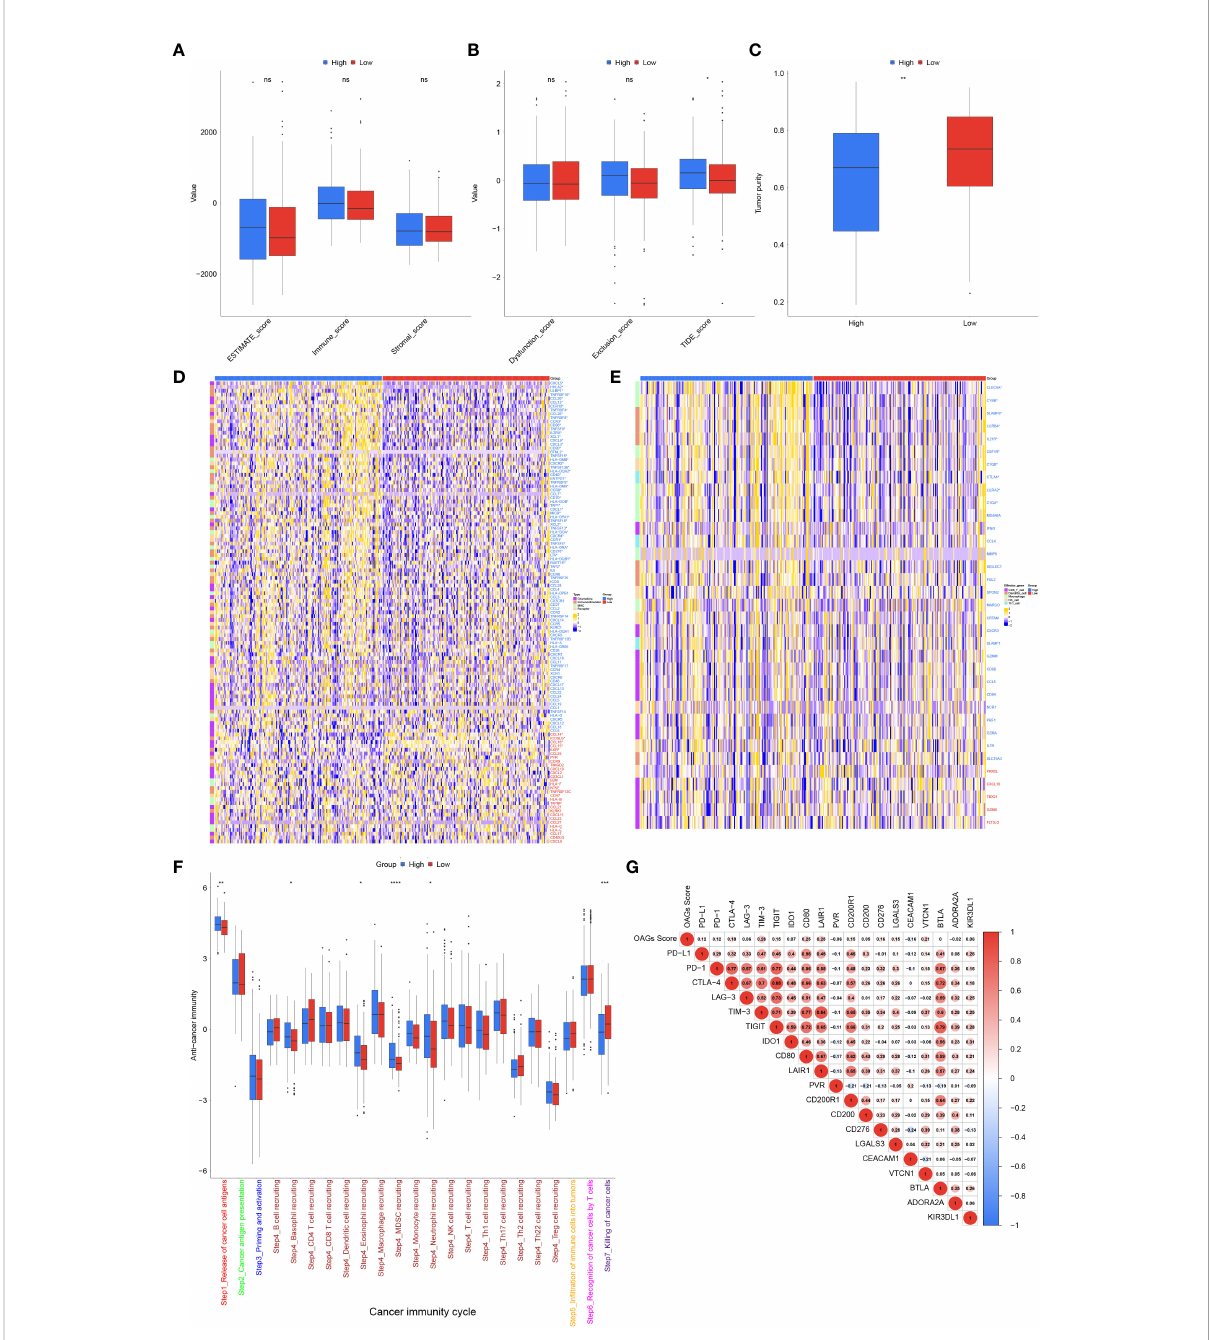
FIGURE 7 Tumor microenvironment (TME) associated with OAG score. (A) The stromal, immune, and ESTIMATE scores between high and low OAG score groups. (B) The dysfunction, exclusion, and TIDE score between high and low OAG score groups. (C) The evaluation of tumor purity. (D) Comparison of immunomodulator-related gene expression between high and low OAG score groups. (E) Transcriptomic pro fi ling of effector genes of tumor-in fi ltrating immune cells in high and low OAG score groups. (F) Evaluation and comparison of anti-cancer immunity by cancer immunity cycle between high and low OAG score groups. (G) Correlation between OAG score and immune inhibitory checkpoint gene expression. OAG, overweight/obesity-associated